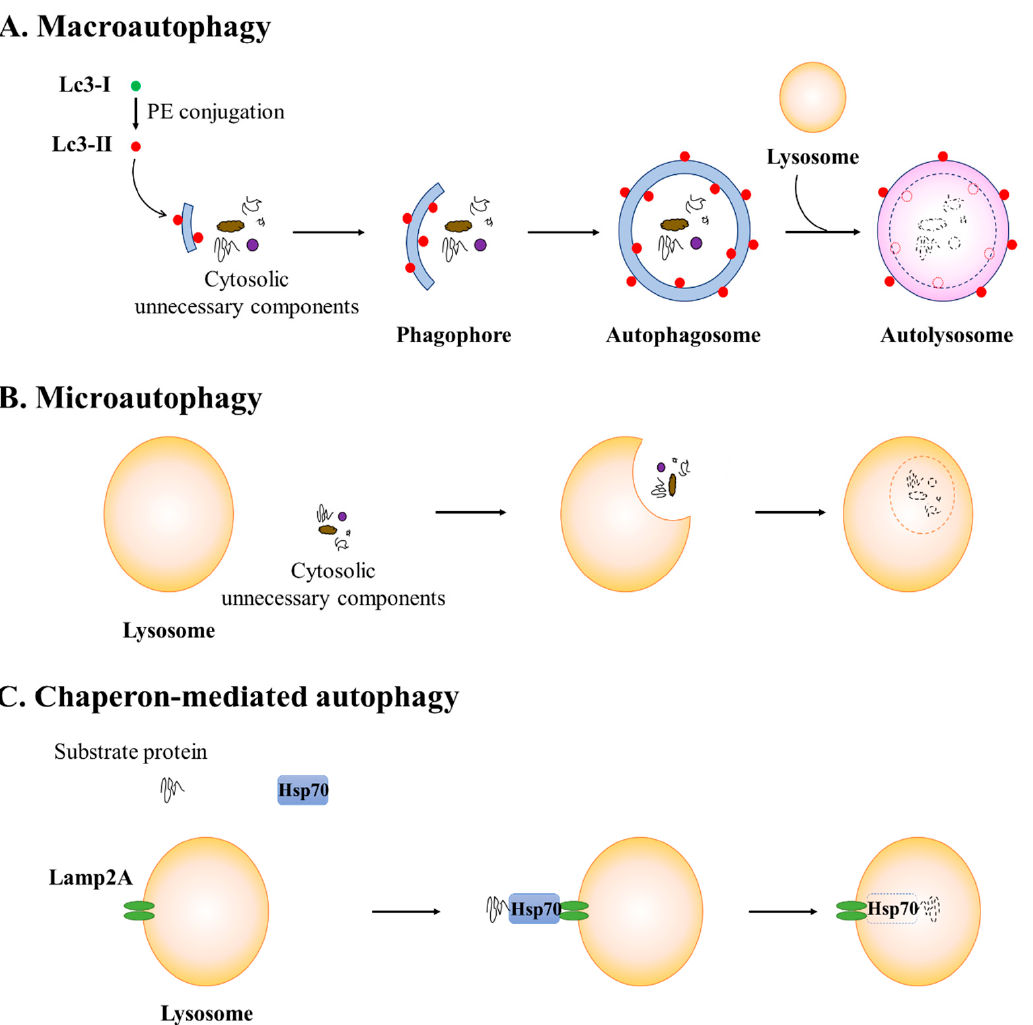
Figure 1. Three types of autophagy. There are three types of autophagy, depending on the cargo delivery system to the lysosome. ( A ) In macroautophagy, cytosolic components are sequestered within autophagosomes, which subsequently fuse with lysosomes. ( B ) By contrast, in microau- tophagy, lysosomes directly sequester the cytosolic components. ( C ) In chaperone-mediated au- tophagy, heat shock protein 70 chaperon (Hsp70) recognizes substrate proteins and delivers them to lysosomal-associated membrane protein type 2A (Lamp2A) in the lysosome membrane. The substrate proteins are translocated to the lysosomal lumen for degradation by lysosomal enzymes. Abbreviations: Atg, autophagy-related gene; Lc3, microtubule-associated protein 1 light chain 3; PE,